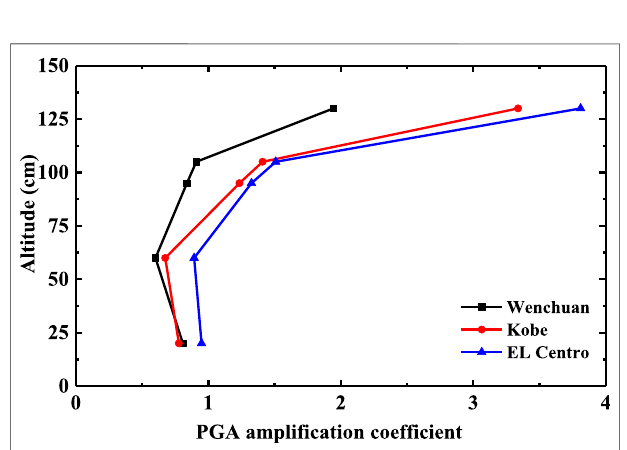
FIGURE 9 | PGA ampli fi cation coef fi cient of slope body under different seismic wave.